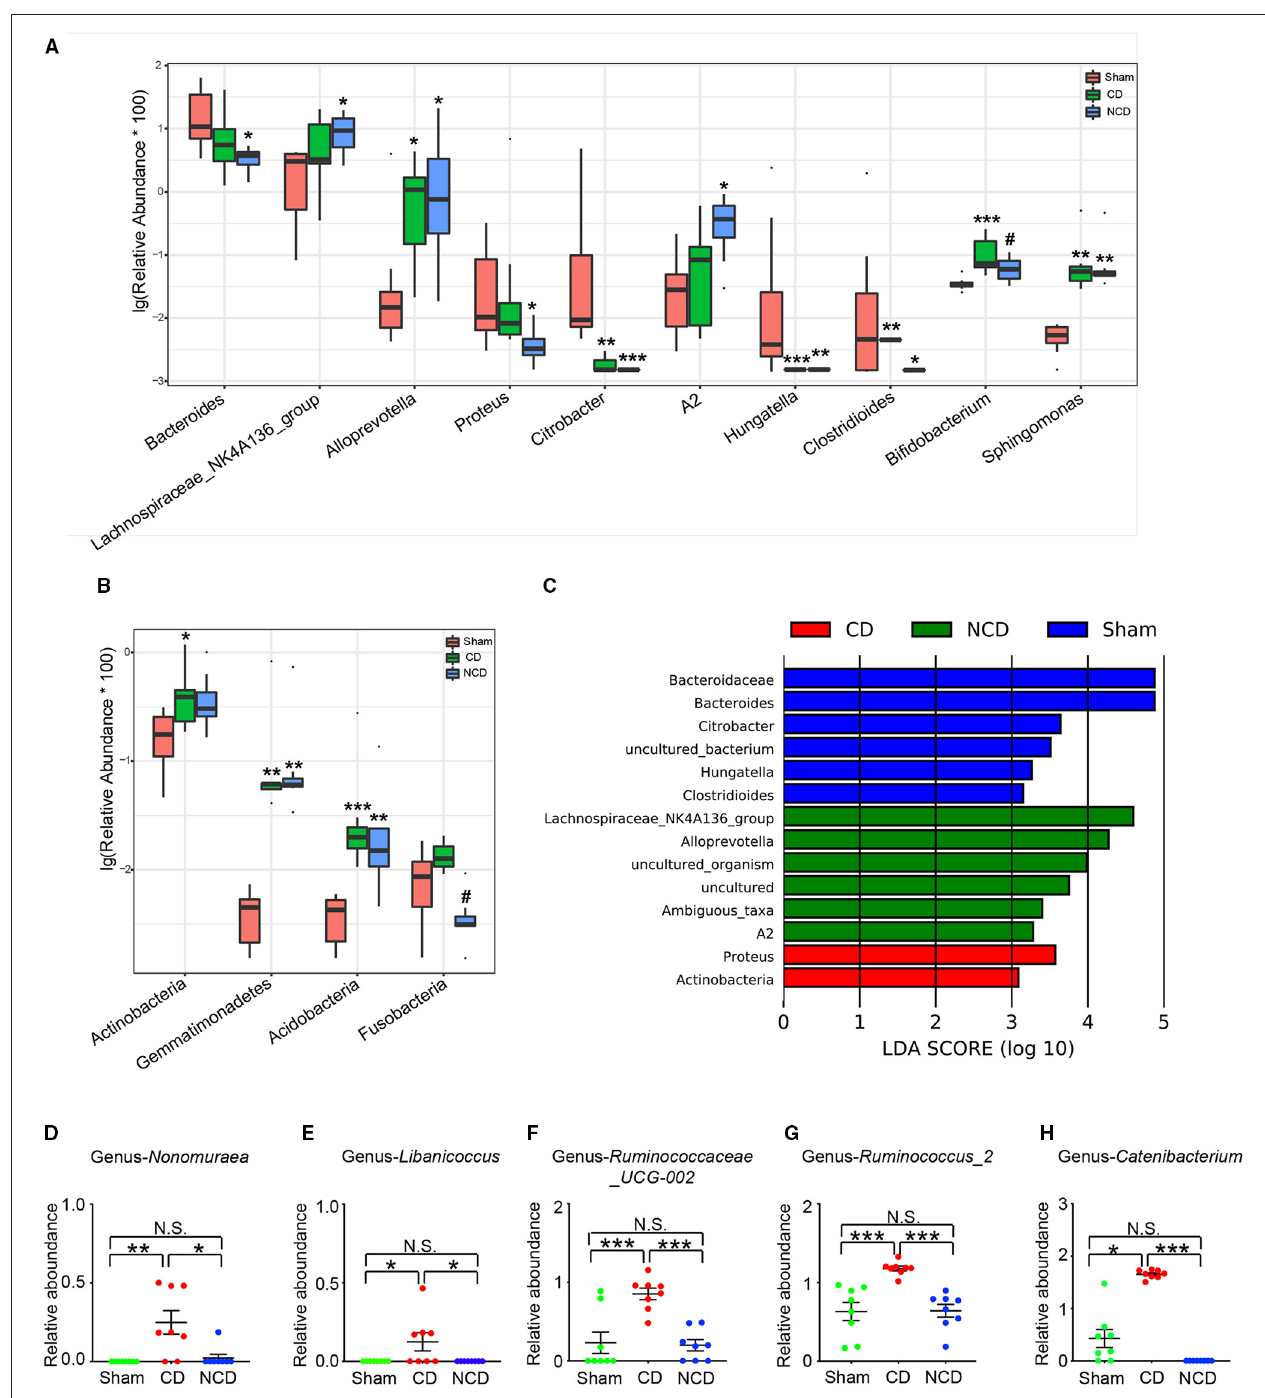
FIGURE 3 | Microbiota with significant changes at phylum and genus levels among the groups. (A) The top 10 flora with significant difference among the groups at genus level: Bacteroides [Kruskal–Wallis non-parametric test, H (2, 21) = 8.205; P = 0.02]; Lachnospiraceae-NK4A136-group [Kruskal–Wallis non-parametric test, H (2, 21) = 6.14; P = 0.046]; Alloprevotella [Kruskal–Wallis non-parametric test, H (2, 21) = 8.315; P = 0.02]; Proteus [Kruskal–Wallis non-parametric test, H (2, 21) = 8.05; P = 0.02]; Citrobacter [Kruskal–Wallis non-parametric test, H (2, 21) = 17.92; P = 0.0001]; A2 [Kruskal–Wallis non-parametric test, H (2, 21) = 7.985; P = 0.02]; Hungatella [Kruskal–Wallis non-parametric test, H (2, 21) = 15.91; P = 0.0004]; Clostridioides [Kruskal–Wallis non-parametric test, H (2, 21) = 10.64; P = 0.005]; Bifidobacterium [Kruskal–Wallis non-parametric test, H (2, 21) = 11.33; P = 0.0035]; Sphingomonas [Kruskal–Wallis non-parametric test, H (2, 21) = 15.44; P = 0.0004]. (B) The